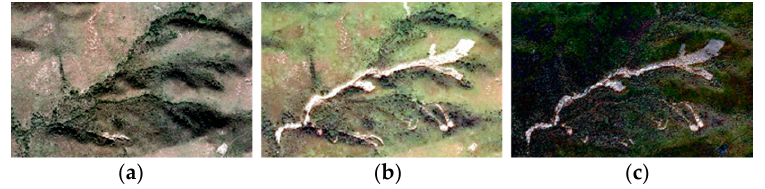
Figure 1. The bitemporal images and their difference image: ( a ) pre-event image at t 1 , ( b ) post-event image at t 2 , and ( c ) the difference image.